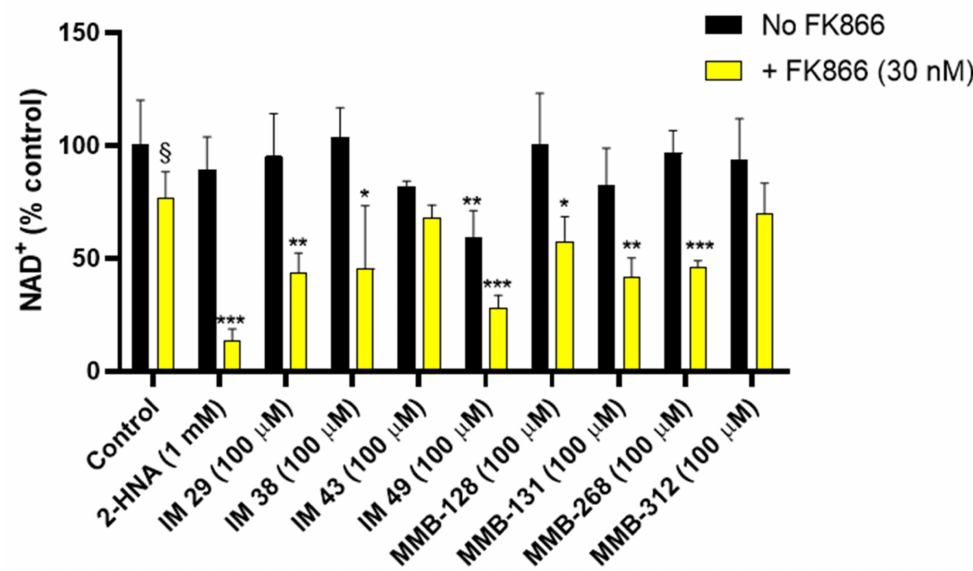
Figure 3. A subset of test compounds cooperates synergistically with FK866 in decreasing intracellular NAD + levels in OVCAR-5 cells. The compounds were administered to cells alone or in combination with FK866 for 20 h. Quantification of NAD + was performed via an enzyme cycling assay and normalized to cell lysate protein content. The results are the mean ± SD of two technical replicates with two biological replicates each. *, p < 0.05; **, p < 0.01; ***, p < 0.001 vs. the respective control, i.e., FK866-untreated control for the test compounds that were administered alone to cells, and FK866- treated control for the combinations of test compound and FK866; §, p < 0.05 versus FK866-untreated, control